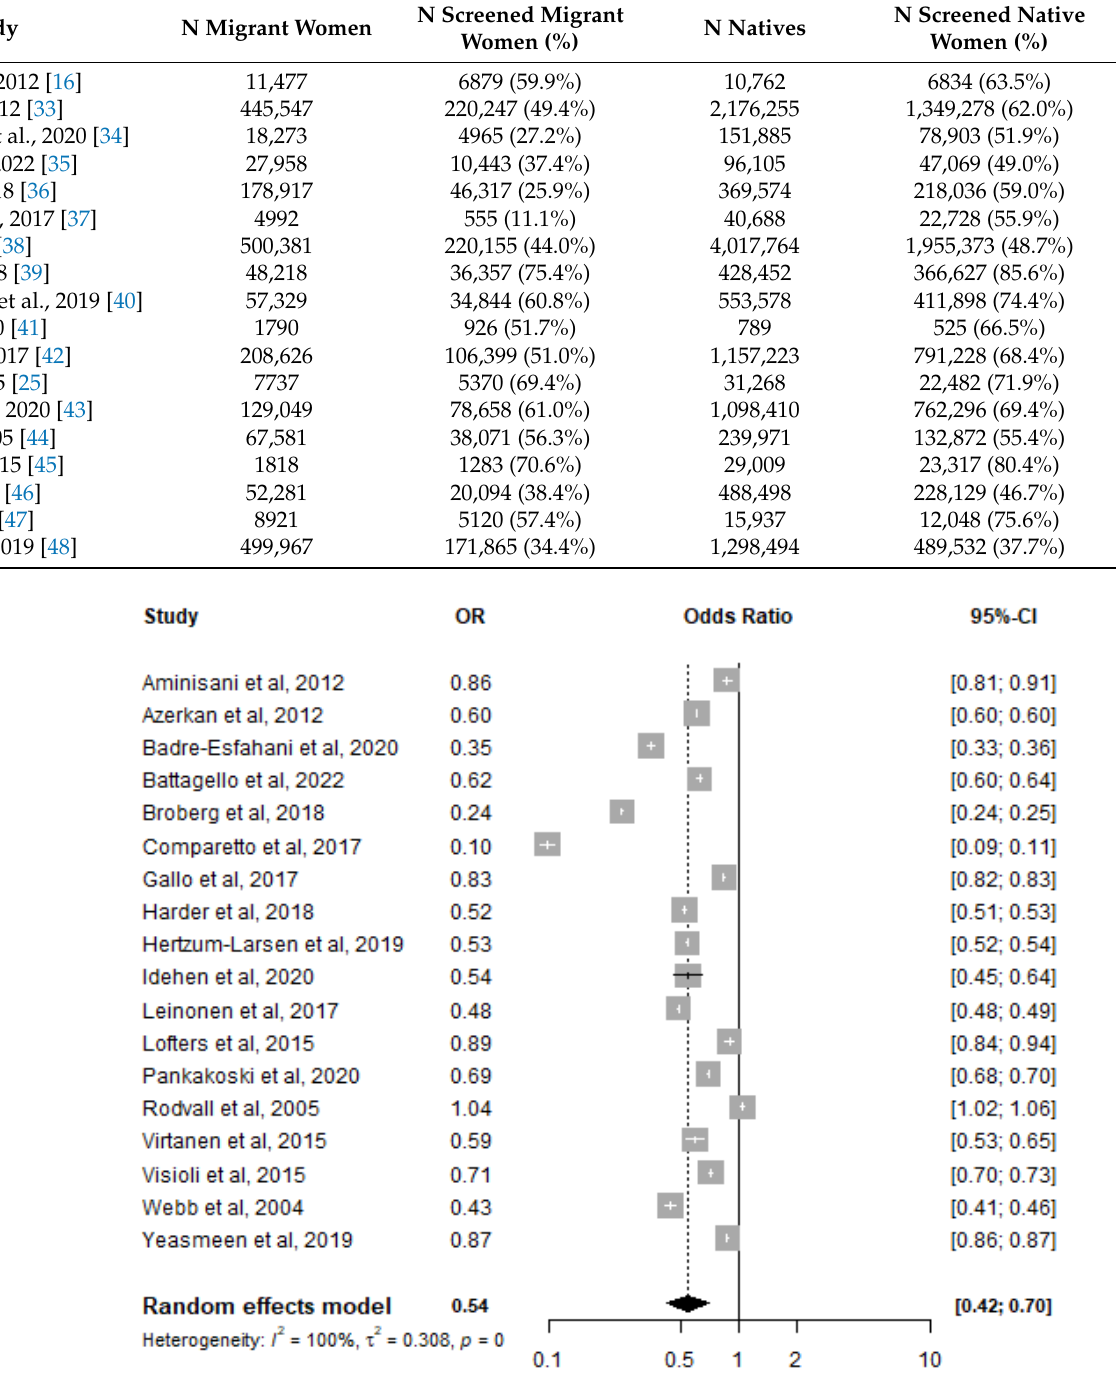
Figure 2. Forest plot for screening participation among all migrant populations, compared to native populations [16,25,33–48].